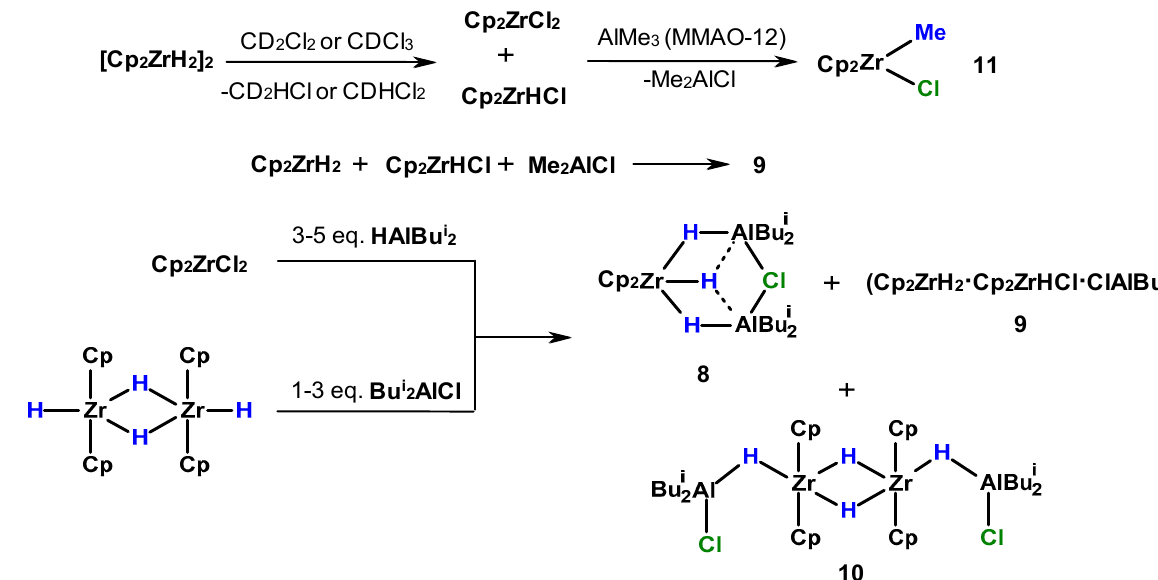
Figure 1. 1 H NMR spectrum of the system [Cp 2 ZrH 2 ] 2 -ClAlBu i2 -MMAO-12 in CD 2 Cl 2 (T = 298 K): ( a )